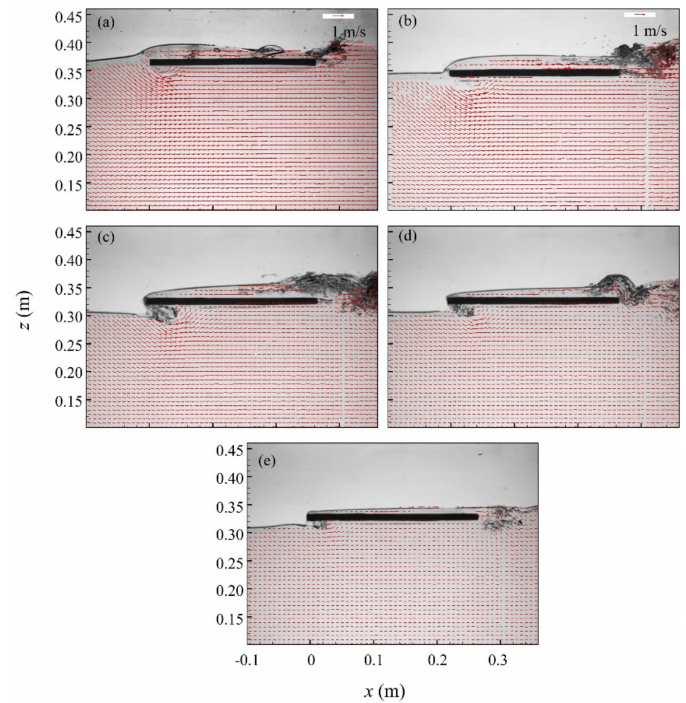
Figure 8. Same with Figure 7 for T = 0.69 (Phase B). ( a ) Case 1, D / h = 6/30, H / h = 10/30; ( b ) Case 2, D / h = 4/30, H / h = 10/30; ( c ) Case 3, D / h = 2/30, H / h = 10/30; ( d ) Case 4, D / h = 2/30, H / h = 8/30; ( e ) Case 5, D / h = 2/30, H / h =